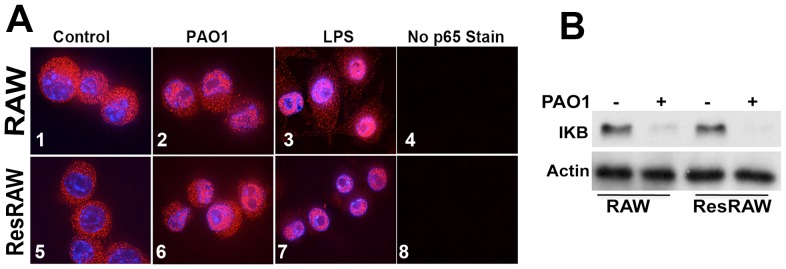
NF-kB activation in naïve and resistant RAW 264.7 cells.
A) Naïve and resistant RAW 264.7 cells (ResRAW) were exposed to PAO1 (MOI 10) or to LPS (100 ng/ml) for 1 h. Note the translocation of the p65 subunit of NF-kB to the nucleus in both cell types. For the right-hand most images, preparations that received no primary antibody were viewed in the red channel. B) To quantitate the inhibitor of NF-kB (IKB), cells were exposed to PAO1 for 1 h, harvested and processed for Western blot analysis to detect IkB and b-actin. Note the major reduction in total IKB.